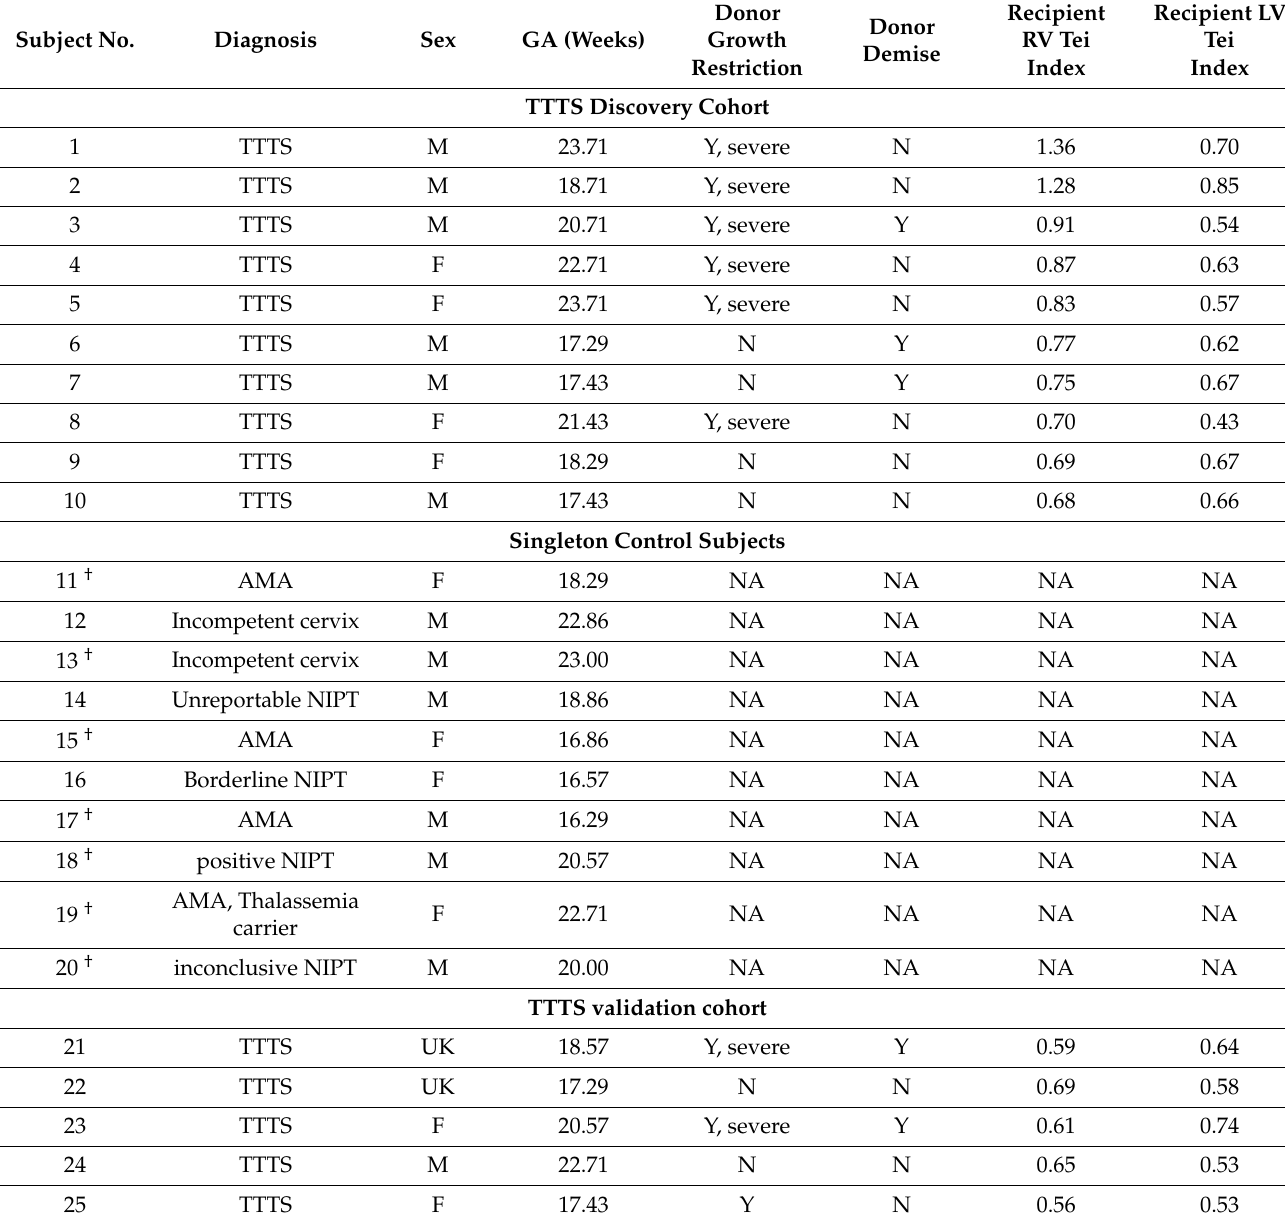
Table 1. Subject